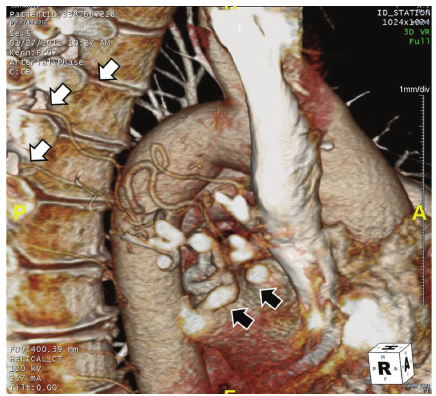
Figure 5: On 3D CT image, AVM was seen feeding from bronchial arteries (white arrows), draining to right pulmonary vein (black